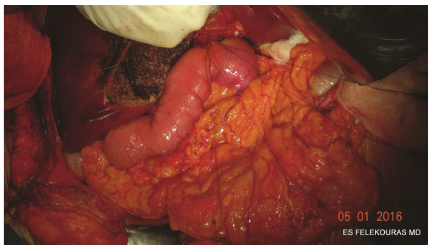
Figure 4: Anterior row of sutures placed to complete the approxi- mation of the jejunum and bile duct.